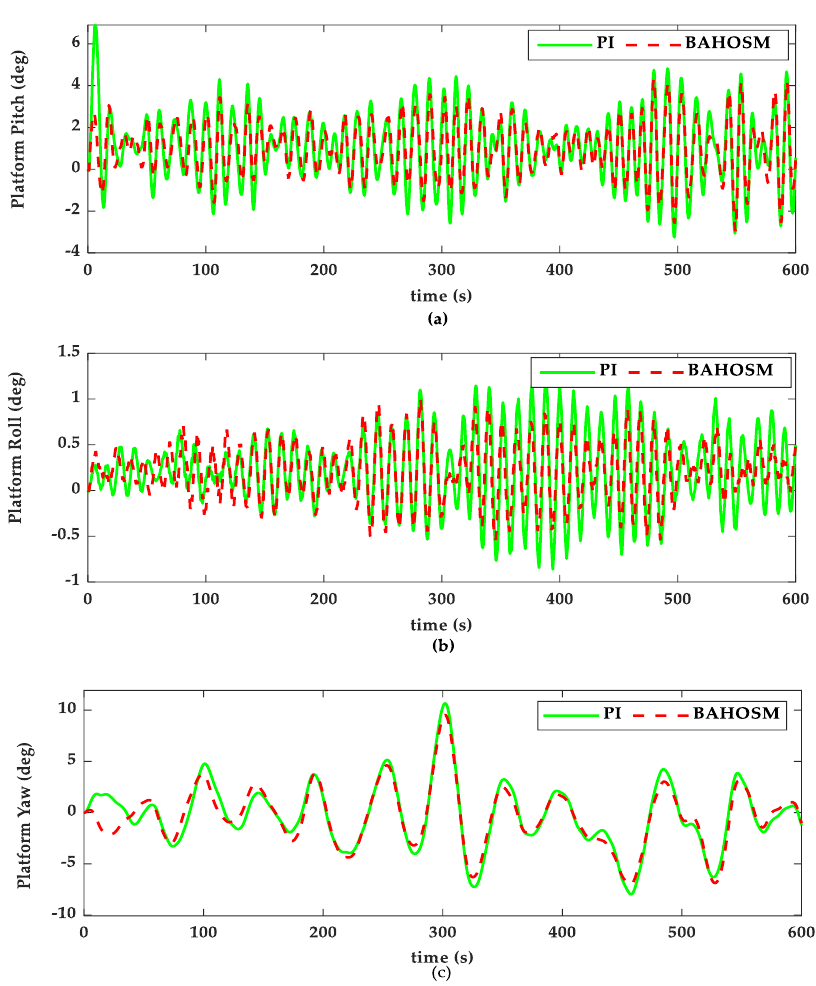
Figure 6. Platform motion response in Case 1.